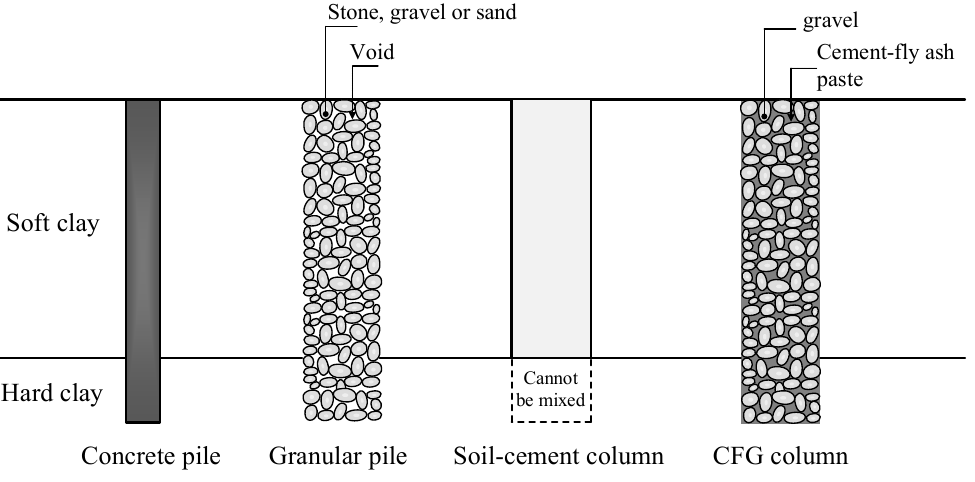
Figure 2. Various types of columns used for supporting the embankments on a soft clay foundation.